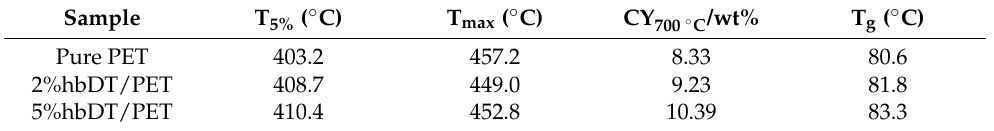
Figure 3. ( a ) TGA and ( b ) DTG curves of PET and different hbDT/PET composites in nitrogen atmosphere. Table 1. TG and DTG data of PET and different hbDT/PET composites.